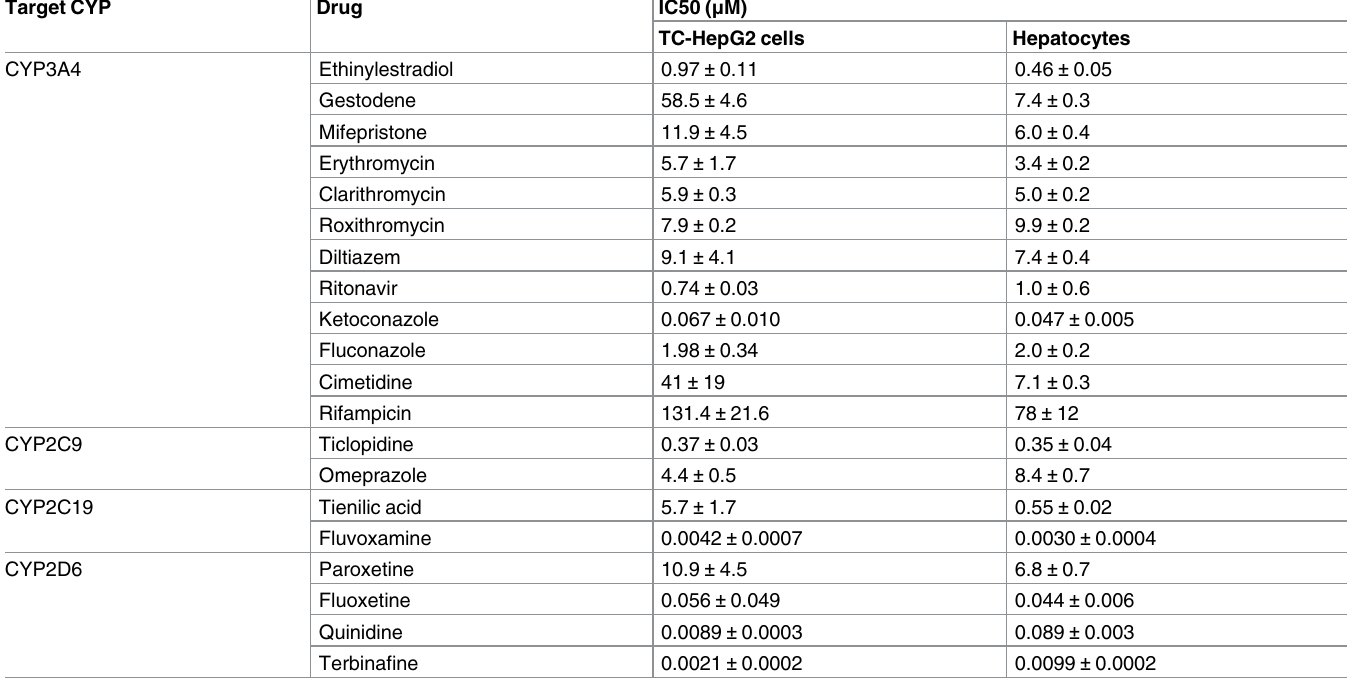
Table 2. Summaryof in vitro inhibition data for CYP3A4, CYP2C9, CYP2C19,and CYP2D6 for 20 compounds. Values represent means ± S.D. of tripli- cate determinations. Target